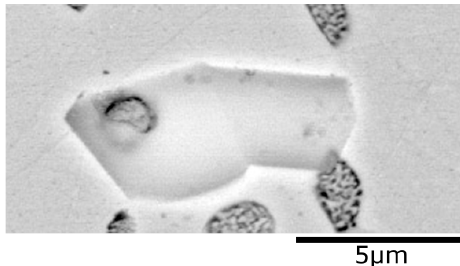
Figure 14. D shape with a high-intensity interior.